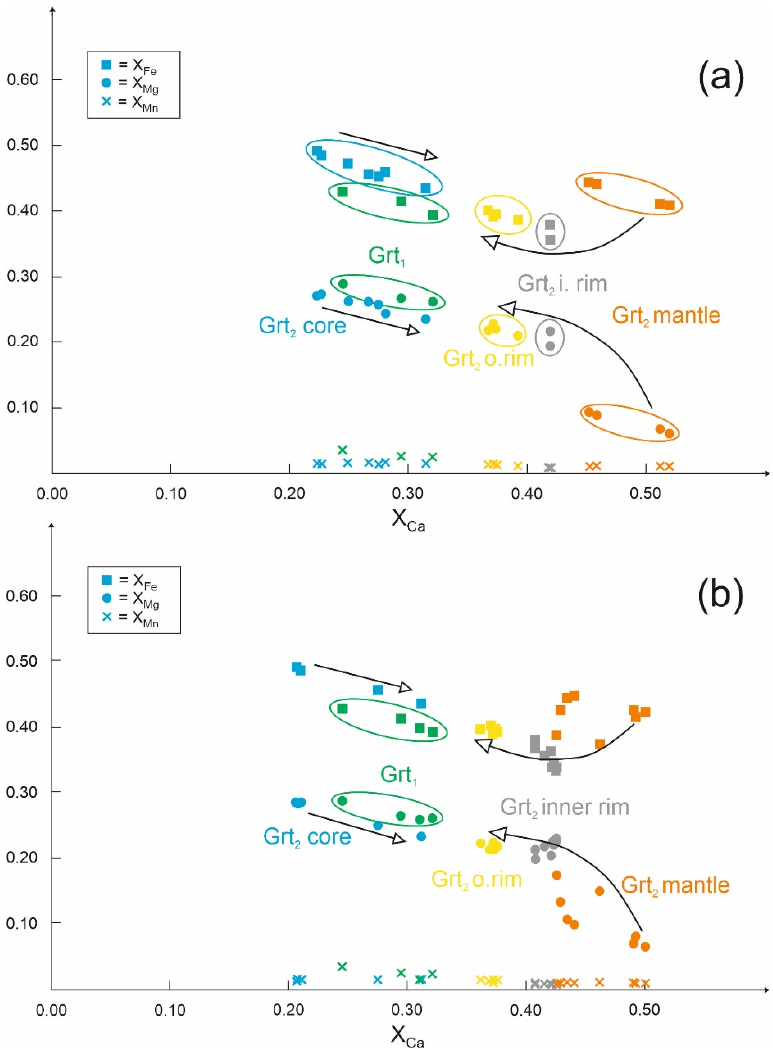
Figure 7. Chemical composition of garnet from vein samples ( a ) MN21V and ( b ) MN22, displayed in terms of molar fractions of grossular and pyrope/almandine/spessartine. The circles discern the different garnet types shown in Figure